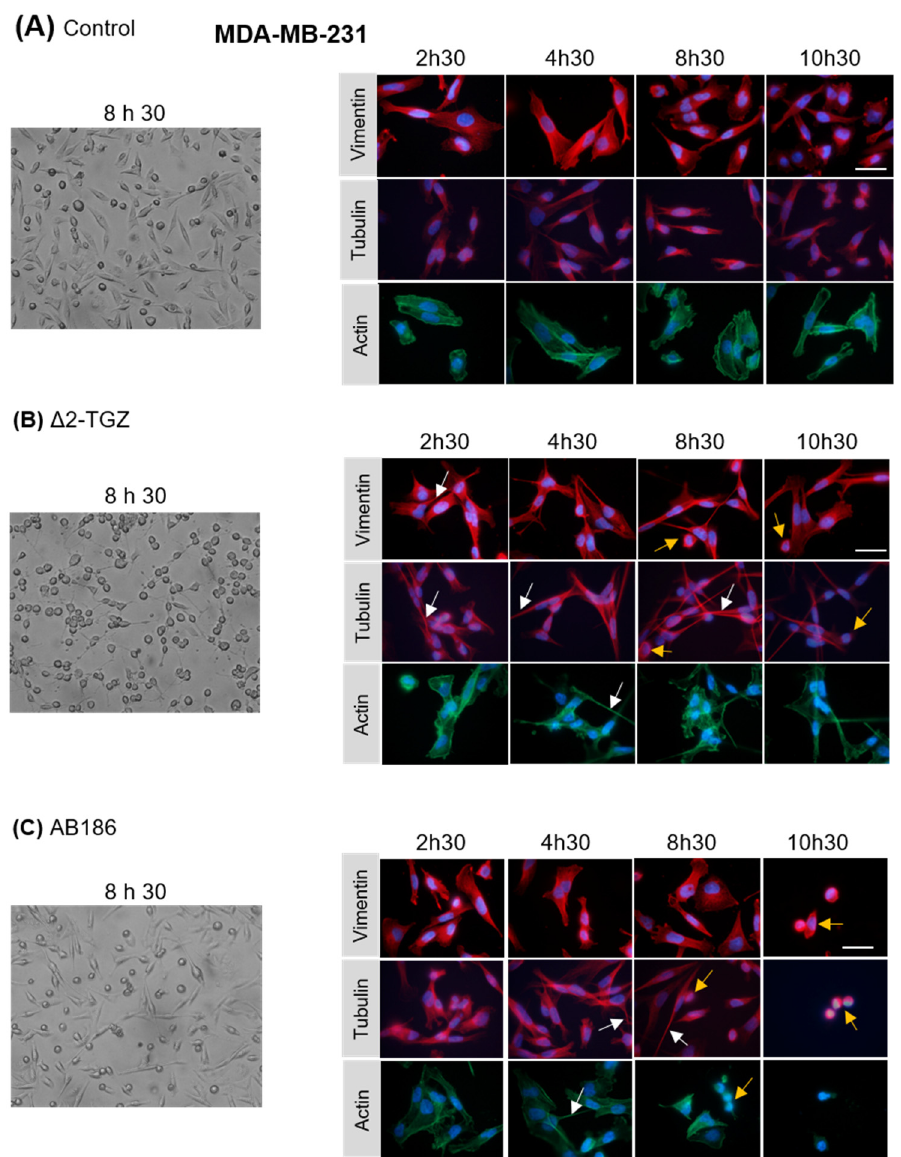
Figure 5. TGZ derivatives alter MDA-MB-231 morphology. MDA-MB-231 cells were treated with DMSO as control ( A ), 20 µM of Δ 2-TGZ ( B ) or 4 µM of AB186 ( C ) during 2 h 30 min, 4 h 30 min, 8 h 30 min and 10 h 30 min. Then, cells were subjected to immunofluorescence analysis and stained with antibodies raised against vimentin, α -tubulin and actin. Cell nuclei were labelled with Hoechst dye. Bright field pictures of control and treated cells are also shown after 8 h 30 min. Elongated cells (white arrows) and some shrunken cells (yellow arrows) were observed. Bar represents 50 µm. Altogether these data confirmed early alterations of the cell morphology, before 4 h 30 min, in agreement with changes in the impedance-based cell